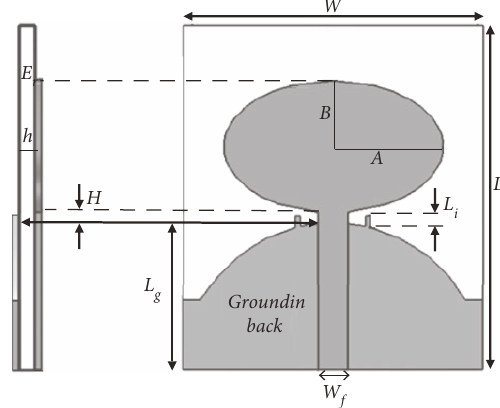
Figure 15: A new design of a UWB monopole elliptical patch was presented for UWB applications